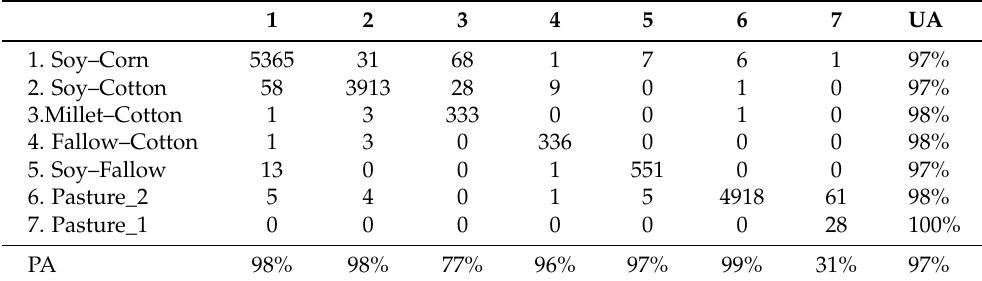
Table 3. Confusion matrix—the cropland samples mapped in pasture were removed from the dataset.